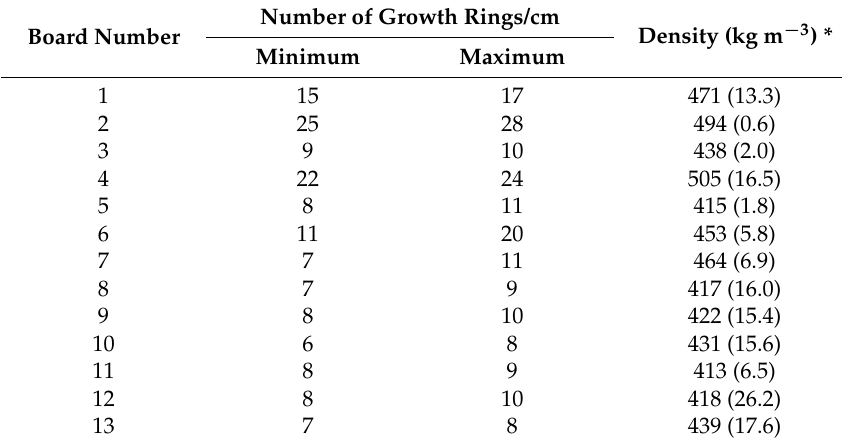
Table 1. Growth ring widths and densities of black spruce boards that were converted into samples used for